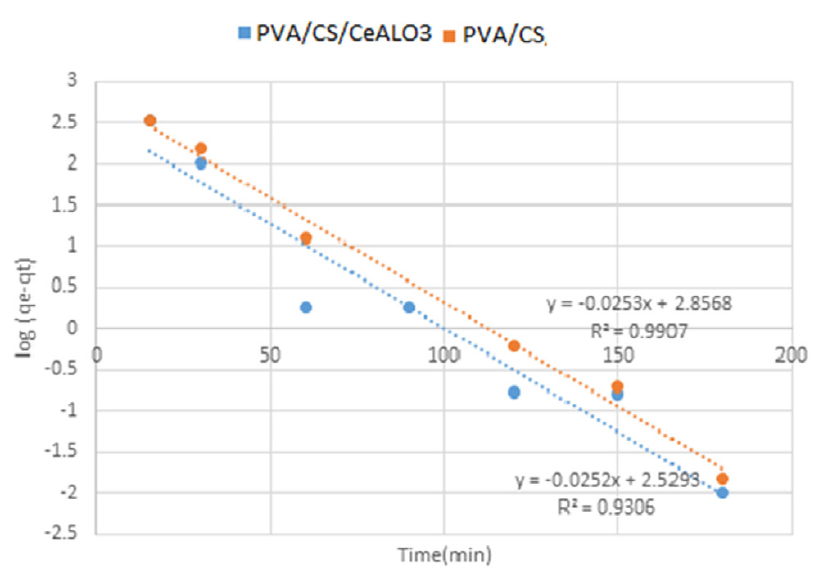
Fig. 10. Pseudo-first-order plot sorption of MB onto PVA/CS and PVA/CS/ CeAlO